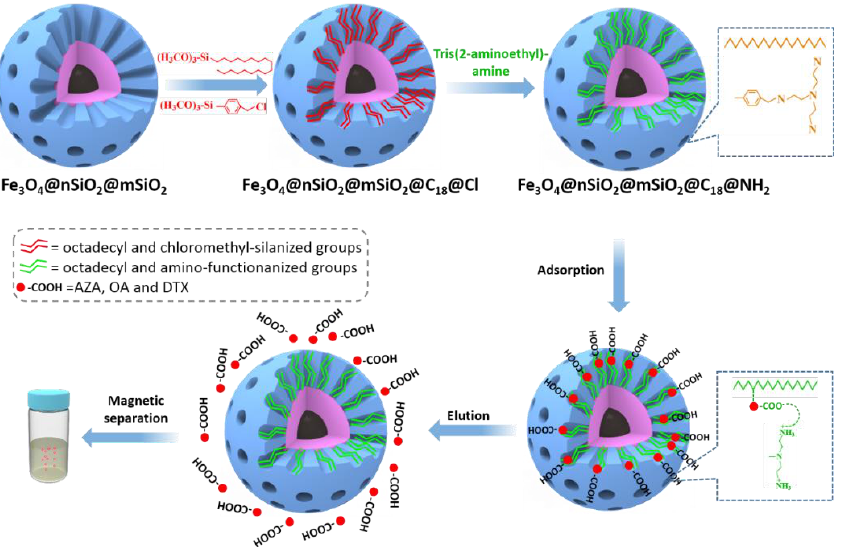
Figure 6. Preparation scheme of magnetic mesoporous silica nanoparticles bifunctionalized with octadecyl (C18) and amino (NH 2 ) and enrichment process of azaspiracids (AZA), okadaic acid (OA) and dinophysistoxins (DTX) (Reprinted with permission from reference [64]).